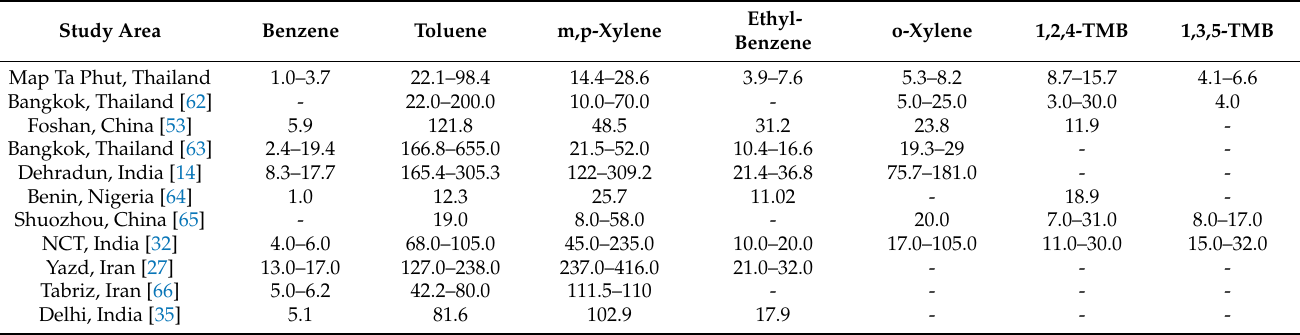
Table 3. Ozone formation potential in this study compared with other studies.